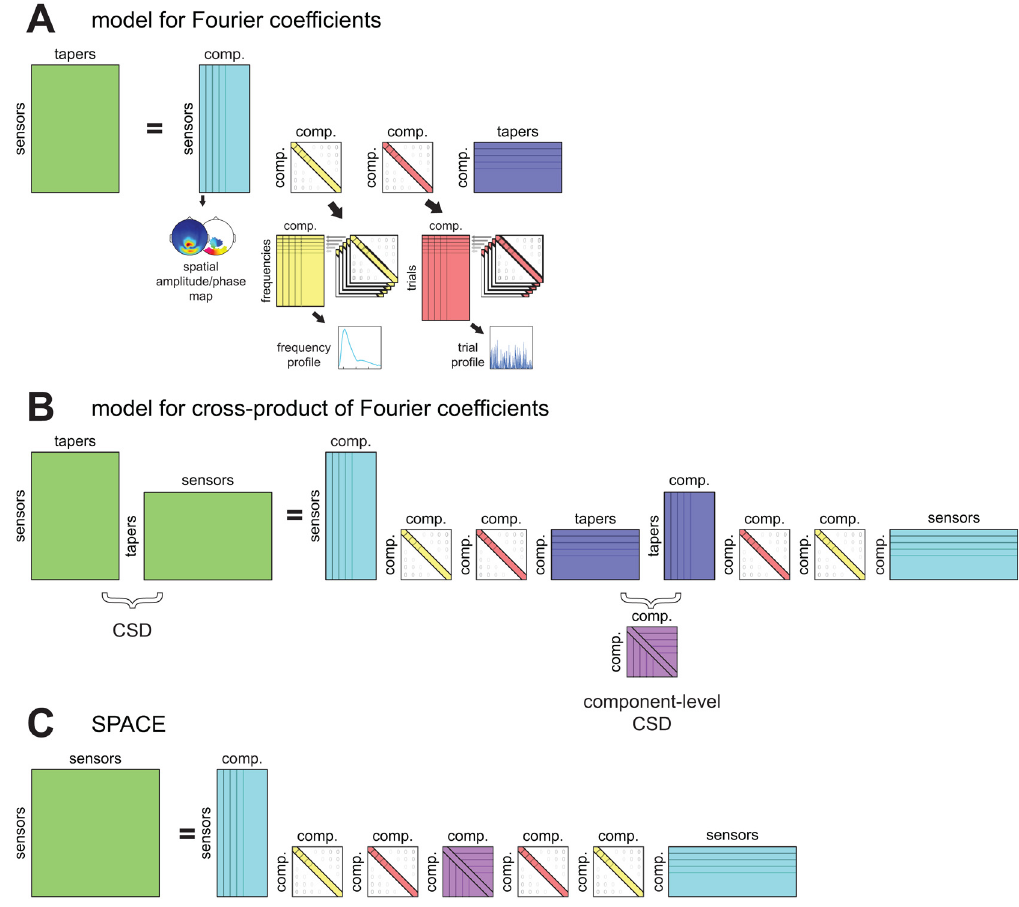
Fig 1. A model for characterizing between-sensor phase coupling by rhythmic components. Our method is based on a model that describes patterns of between-sensor phase coupling of oscillations in electrophysiological recordings. These oscillations are described by Fourier coefficients obtained by a spectral analysis using multitapering, which vary of sensors, tapers, frequencies and trials. Components describe the systematic variability in these Fourier coefficients by a spatial amplitude map, a spatial phase map per frequency, a frequency profile, and a trial profile (see Fig 2 for examples). Here we present the model schematically. We start with a model for the observed Fourier coefficients in A, continue with a model for its cross-product in B, and end with the model we use for extracting components in C. A. This model describes the structure in sensor-by-taper matrices of Fourier coefficients (green) per frequency and trial, by the product of four matrices reflecting the four parameter sets. The first (cyan) is complex-valued and contains the spatial amplitude map (see Fig 2B) and frequency-specific spatial phase map (see Fig 2C) for all components. The second matrix (yellow) is real-valued and diagonal, and contains the frequency- specific weighting of components. When combined over frequencies, it forms the frequency profile (see Fig 2A). The third matrix (red) is similar to the second (cyan) but contains the trial-specific loadings, and forms the trial profile (see Fig 2D). The fourth matrix (blue) is complex-valued, and contains the frequency- and trial-specific amplitudes and phases of each taper of each component. B . This is a model for the cross products of the matrices of Fourier coefficients. These cross products are the cross-spectral density matrices (CSDs), and describe between-sensor phase coupling averaged over tapers. The model for the cross products is the cross product of the model in A, and contains the same parameters. In the center there are now the component-by-component cross products of the matrices (purple) that contained taper-specific parameters. Importantly, these component-by-component cross products describe the phase coupling between components averaged over tapers, and is the component-level CSD. This matrix is explicitly modeled in the final model which we use to extract components. C . The final model explicitly models between-component phase coupling by the component-level CSD (purple). Importantly, this is only estimated per frequency , and not per trial and per frequency (see Materials and Methods for a mathematical description of the model). Components according to this model can be extracted using a method denoted as